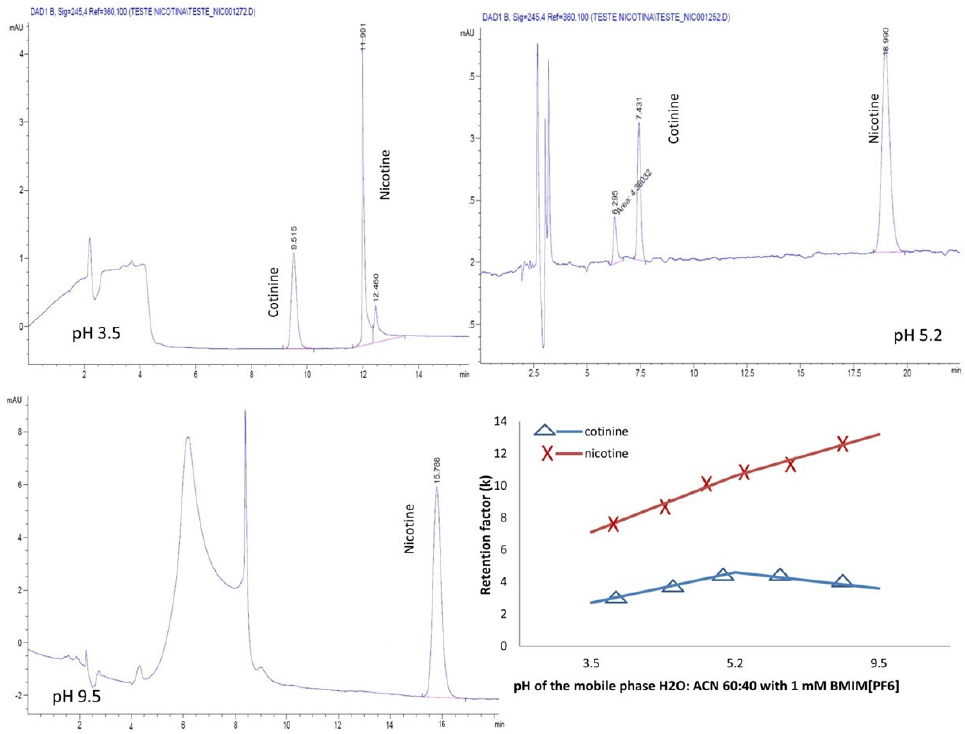
Figure 8. Chromatograms and variation pH ‐ dependent retention factor for nicotine and cotinine with mobile phases containing H 2 O:ACN 60:40 and 1 mM BMIM[PF 6 ] . A different behavior of the analytes was noted in the presence of the ILs